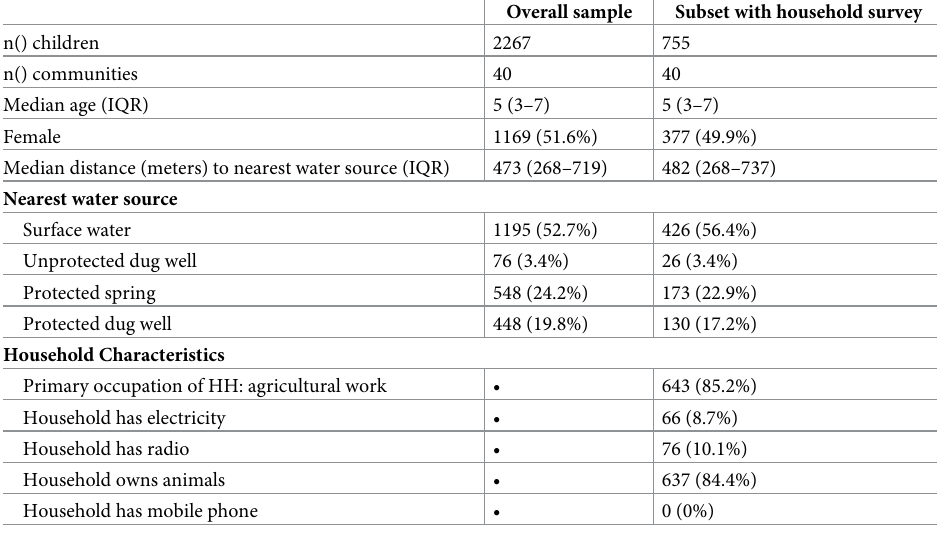
Table 1. Population characteristics in overall population and subset with household survey.